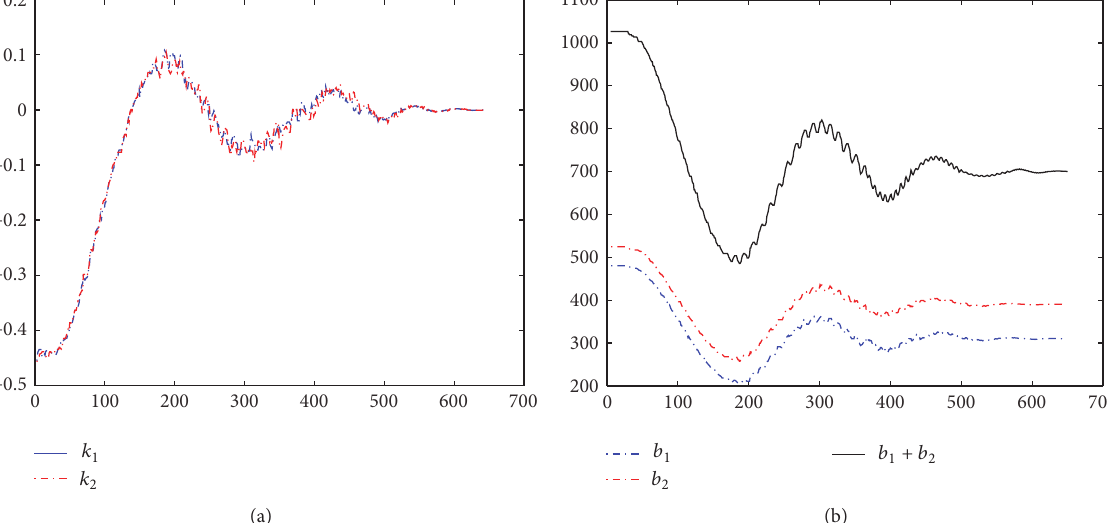
But in practice this rotation will lead to TSR’s deviation from the approaching path and increase the possibility of collision with the target. Hence in future works the control to attitude angle 𝛼 should be added to the